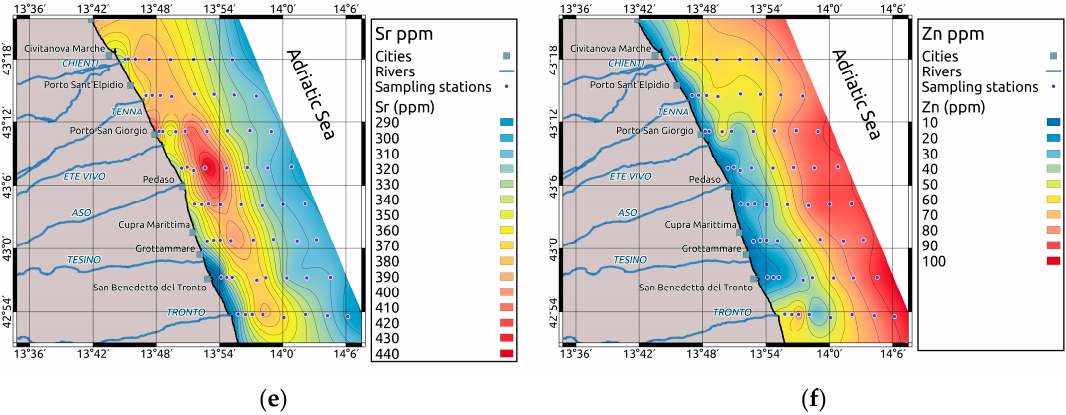
Figure 7. Areal distribution of the elements in surface sediments with C f > 1 in some samples. ( a ) As, ( b ) Ba, ( c ) Ga, ( d ) Pb, ( e ) Sr, and ( f ) Zn.